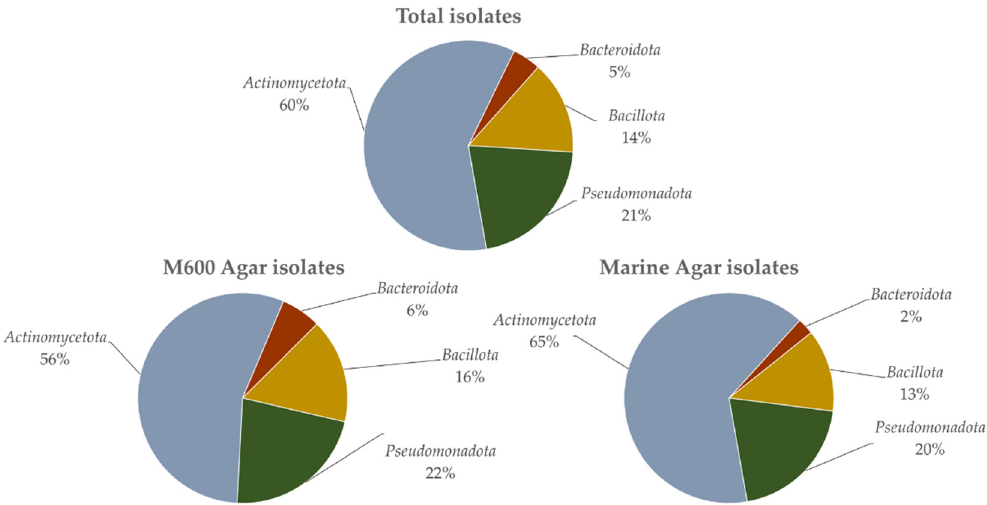
Figure 2. Distribution of isolated strains by phylum in total numbers and by isolation medium (M600 and MA).